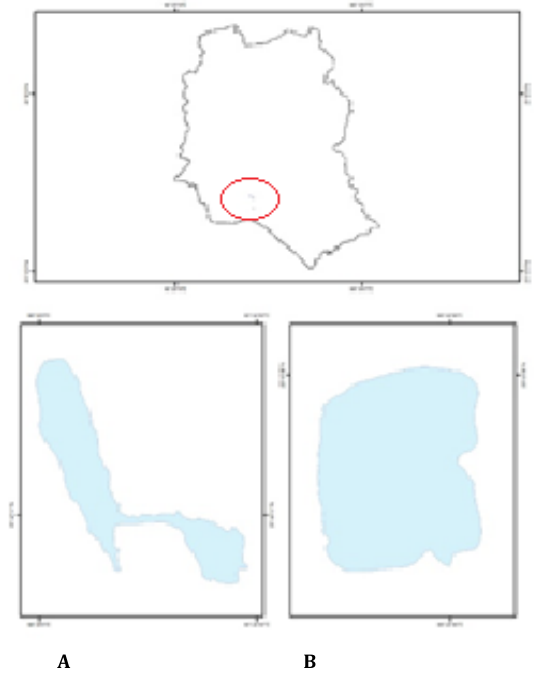
Figure 1: Map of Study Area; (A) Ramna Lake, (B) Shahidullah Hall Pond